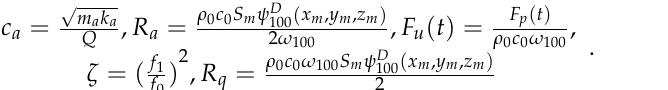
Table 1. The parameters of the system.